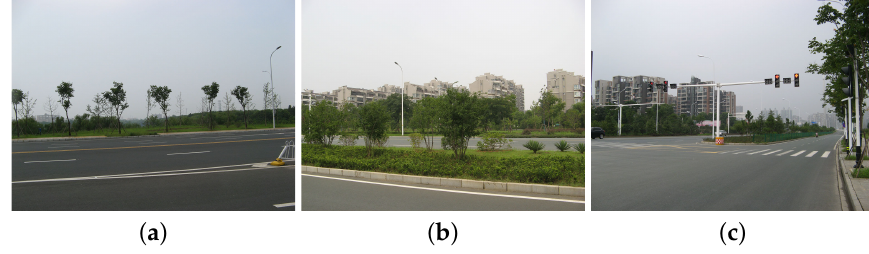
Figure 16. Images of roads surrounding the Jinyin Lake in data set A. a , b , and c are different images of roads. The images were taken on 16 August 2017.